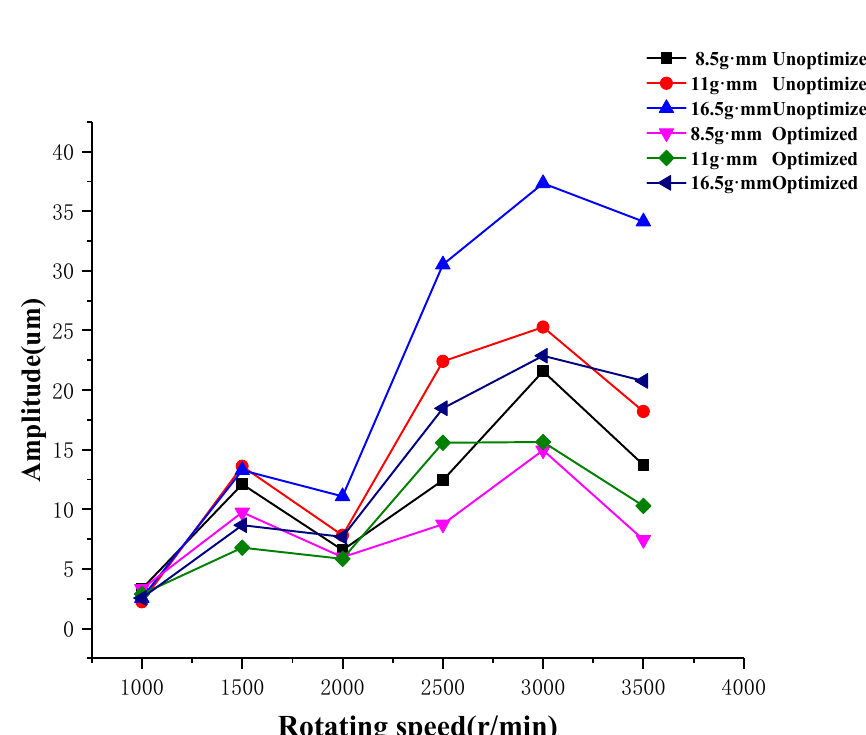
Figure 10. Comparison of balance amplitudes before and after optimization.